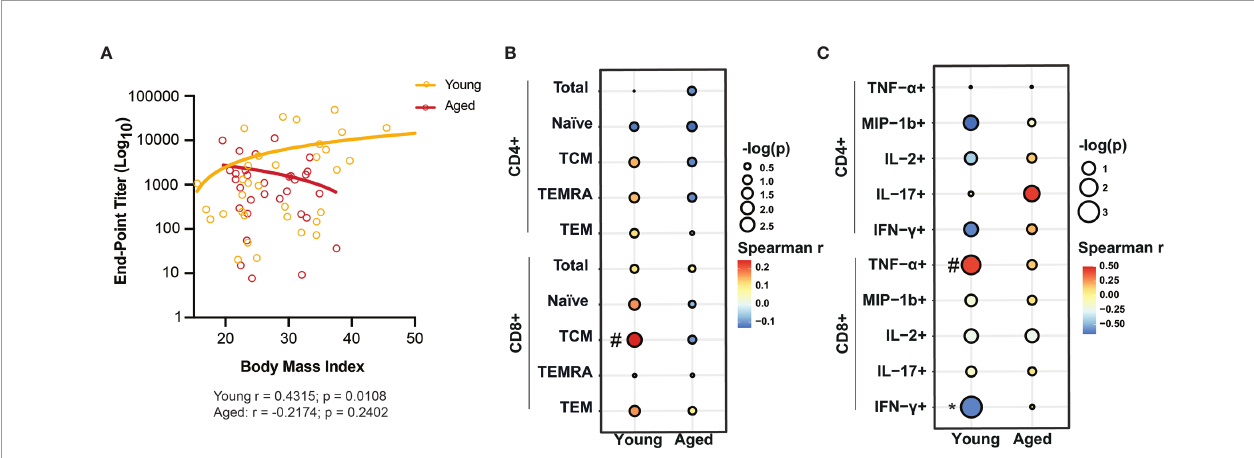
FIGURE 2 | BMI-dependent alterations of adaptive immunity in young and aged COVID-19 patients. (A) Linear regression analysis of IgG end-point titers against nucleocapsid protein (NP) with BMI in young and aged hospitalized COVID-19 patients. (B) Linear regression analysis of the frequency of CD4+ and CD8+ T cell subsets with BMI in young and aged hospitalized COVID-19 patients. (C) Linear regression analysis of the frequency of cytokine producing CD4+ and CD8+ T cells in response to ex vivo anti-CD3/CD28 stimulation with BMI in young and aged hospitalized COVID-19 patients. #p < 0.12, *p < 0.05, **p < 0.01, ***p < 001 and ****p <